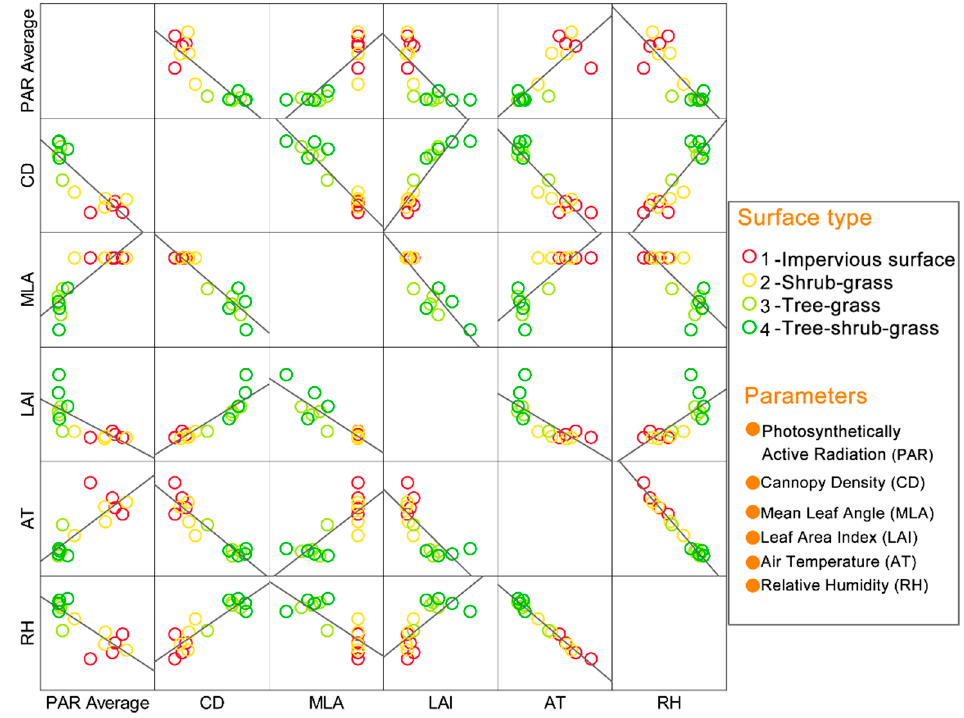
Table 3. Pearson correlation coefficients of the characteristics of surface type on AT and RH.